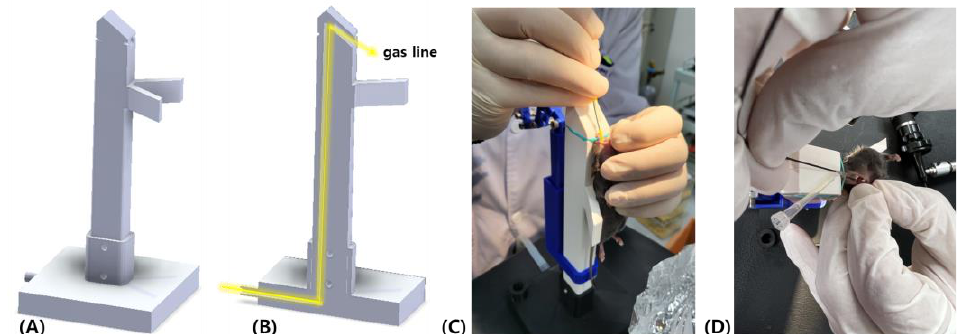
Figure 2. The three-dimensional printed inhalation anesthesia system and fixation stage for rodent models. ( A ) The three-dimensional design of a respiratory anesthesia and rodent holder to assist a drug or toxic substance administration system. ( B ) Half-section view of the system and holder for rodents from the three-dimensional design. ( C ) perspective view and ( D ) plan view pictures of drug or toxic substance administration experiment with a flexible imaging guide after rodent fixation.